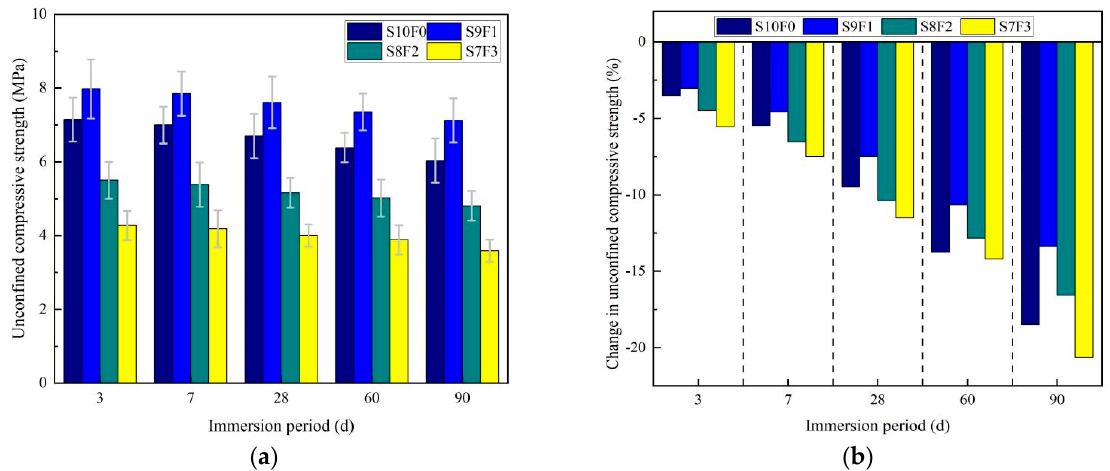
Figure 5. ( a ) The UCS of SF-GSSS immersed in Na 2 SO 4 solution at di ff erent times. ( b ) Change in UCS.